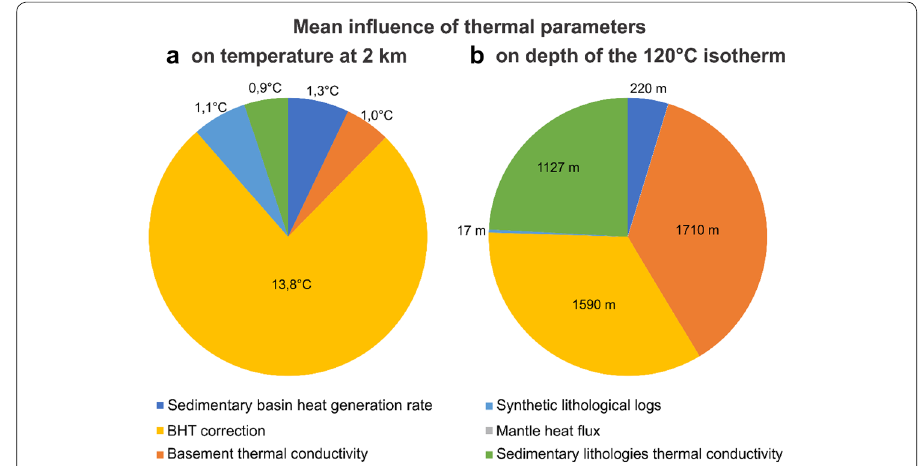
Fig. 12 Average relative sensitivity for all wells used in this study considering each thermal parameter to compute analytical 1D temperature at a 2 km depth and at b depth of the 120 °C isotherm. Impact is calculated from pessimistic and optimistic scenarios for each thermal parameter, while quantifying difference in temperature or isotherm depth (Fig. 11)